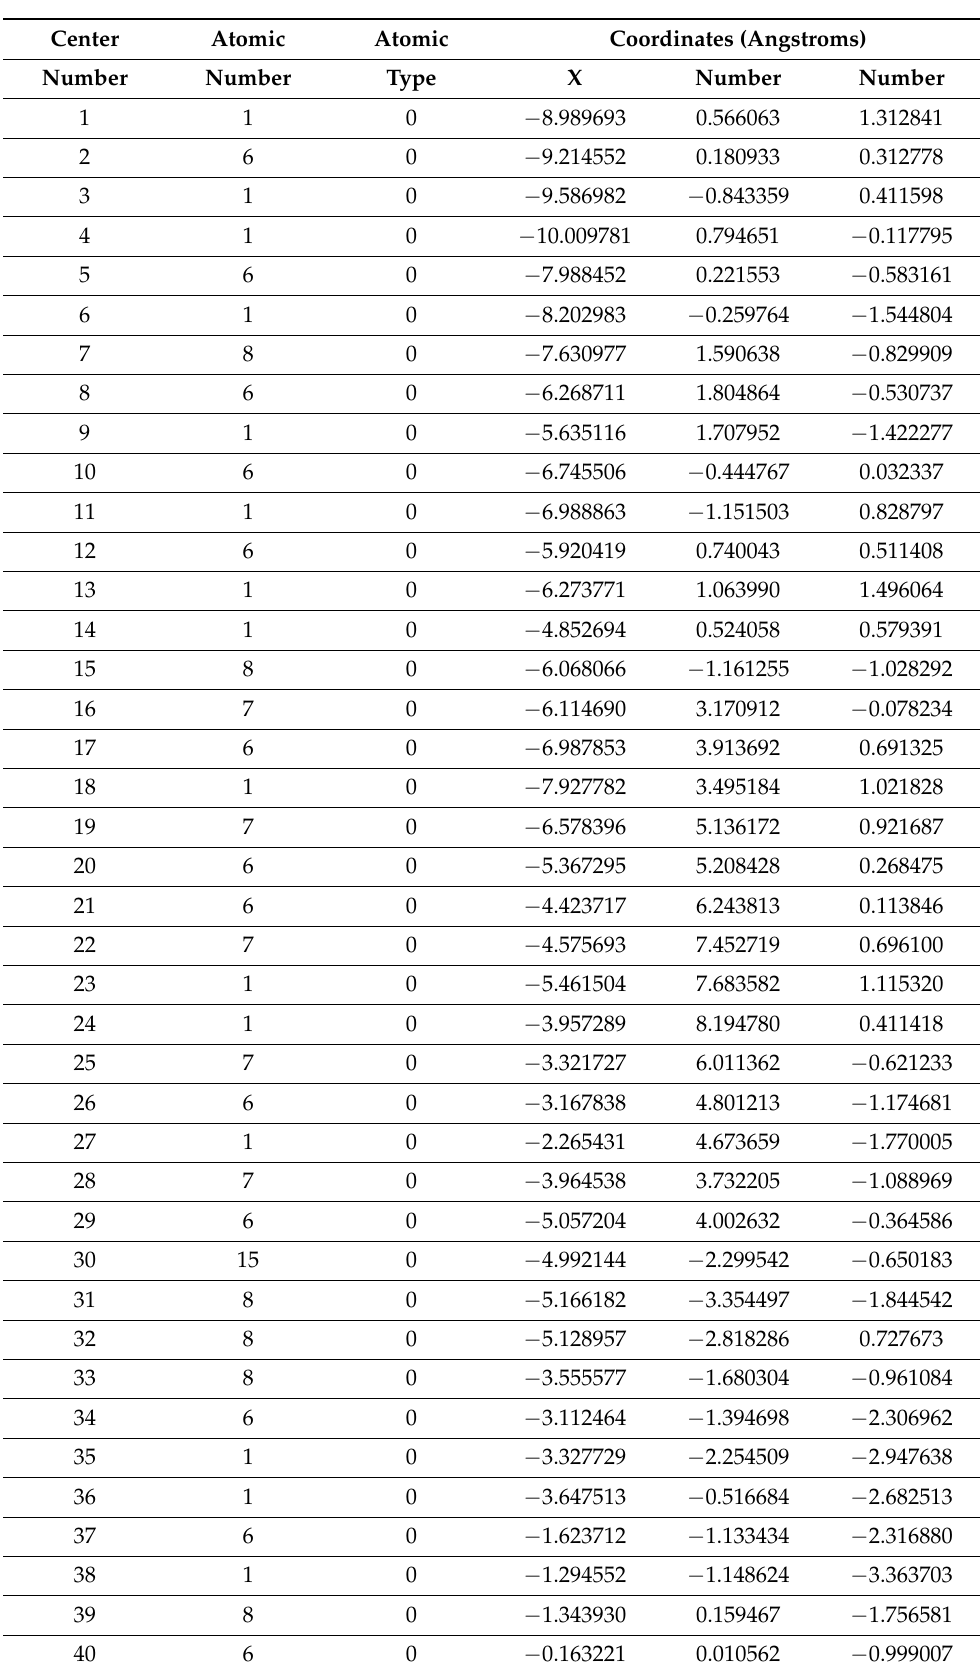
Table A14. Complex LiI 3 with nucleotide triplet